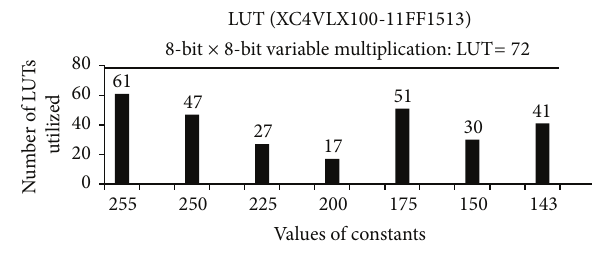
Figure 7: Actual LUT utilization for 𝐴 [7:0] × 8-bit constant.